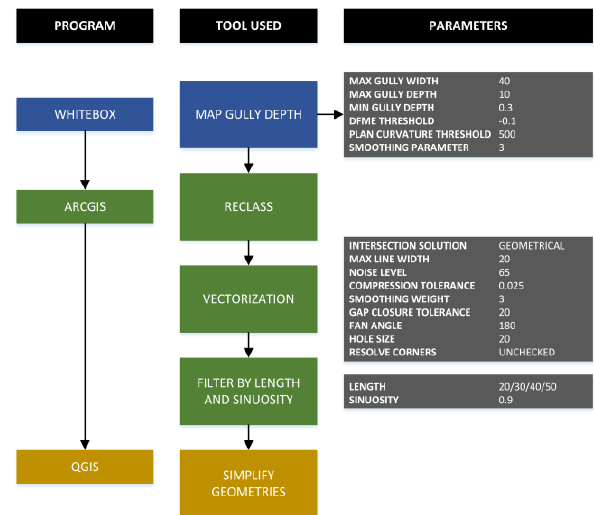
Figure 4. Irrigation network extraction